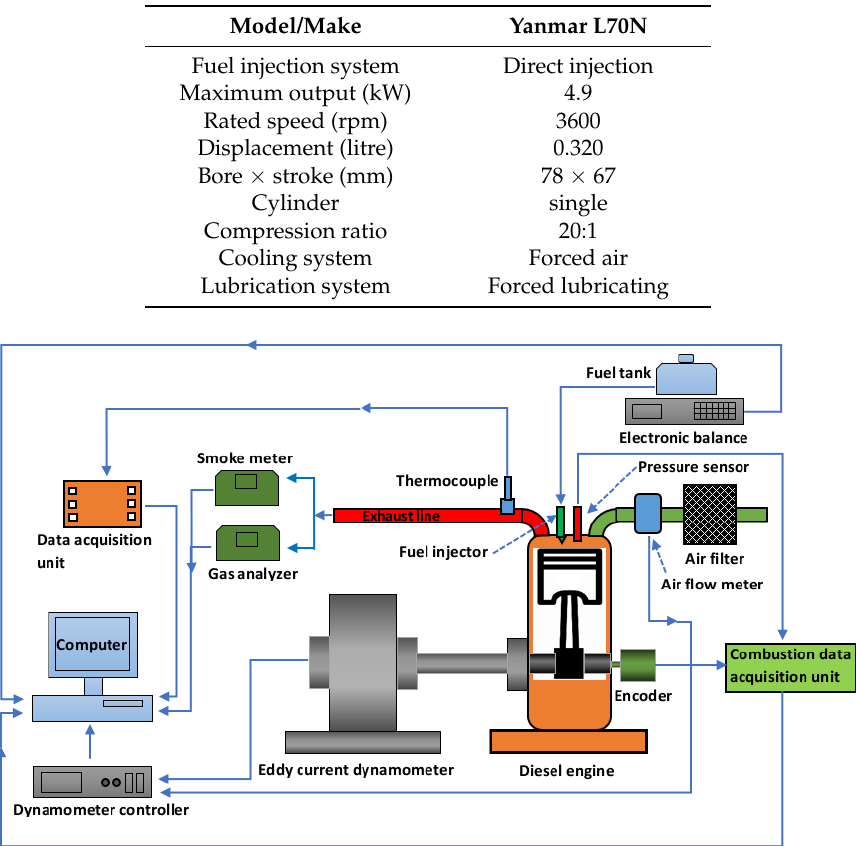
Figure 4. Schematic diagram of engine dynamometer setup.